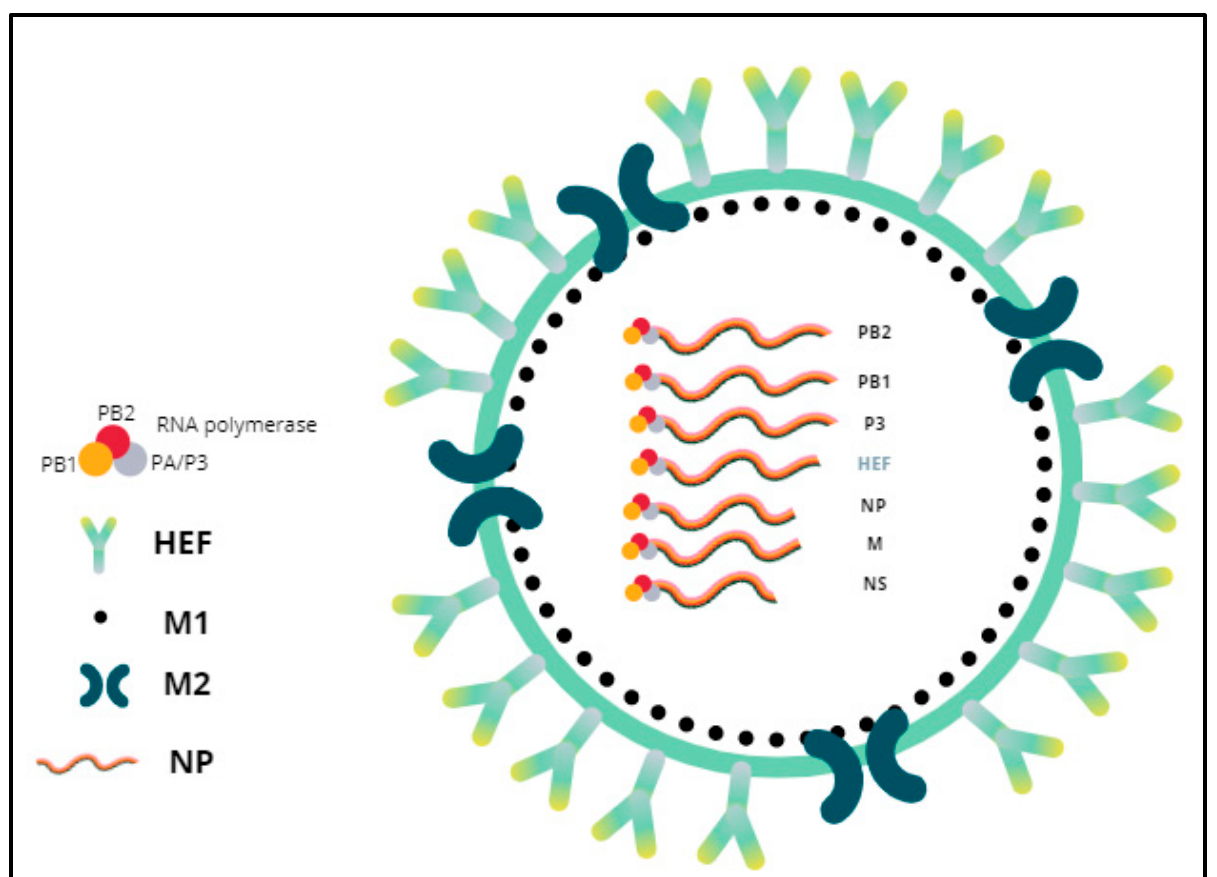
Figure 2. General morphology of influenza D virus. The envelope has membrane proteins HEF and M2. The M1 protein is underneath the membrane surface and encases the virion core that contains the genome. Each vRNA segment forms a vRNP together with the NP and RNA polymerase complex (PB2, PB1 and PA/P3).